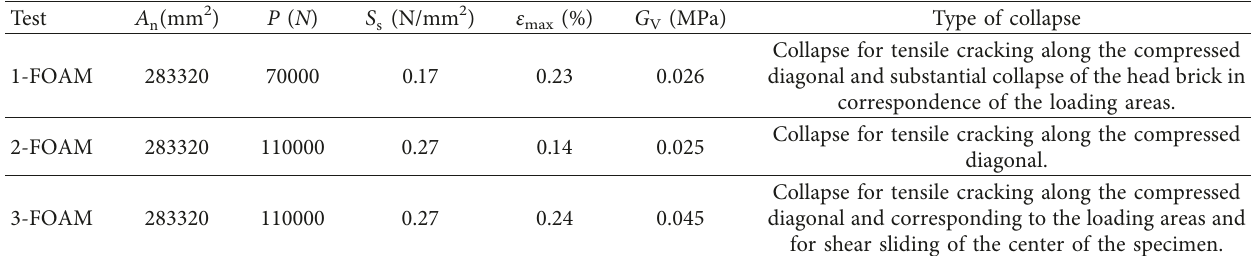
Table 9: Mean shear strength in case of diagonal compression test for masonry with